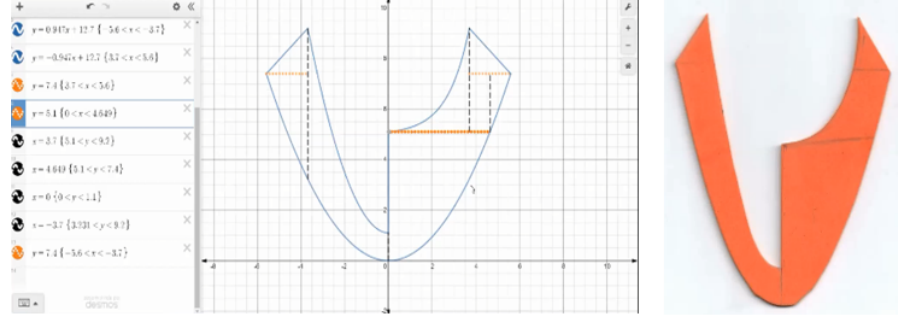
Figure 6. Q2—Desmos use—function and graph, example 3.